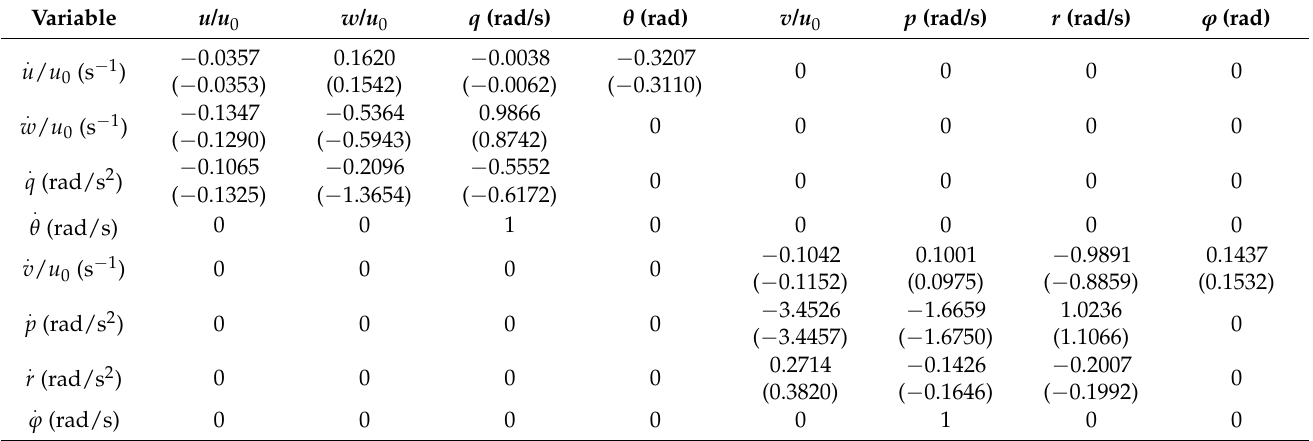
Table 24. CFD–RANS (extrapolated) 8 × 8 stability matrix for flight condition 18 in Tables 4 and 22 (reference takeoff case).